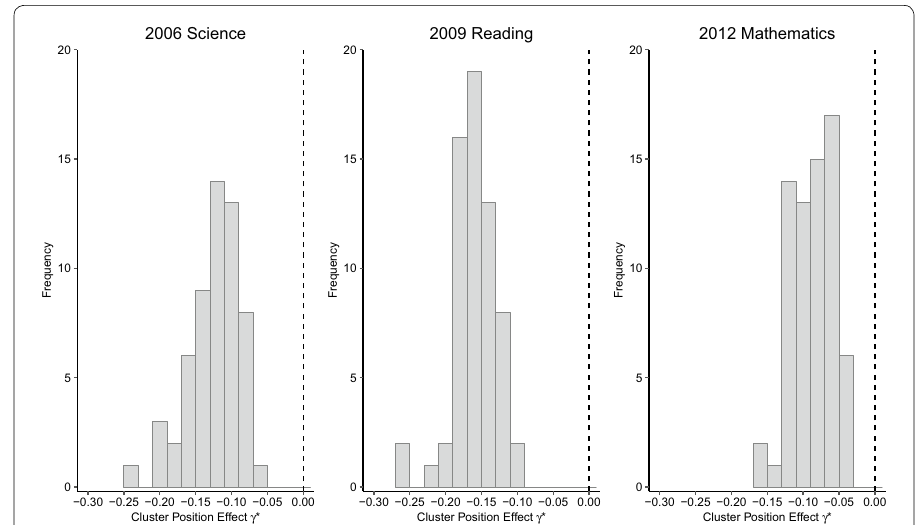
Fig. 1 The histograms of cluster position effects γ ∗ of all countries in the three PISA domains. The dotted lines indicate the value of zero. All effects are significantly different from zero at an alpha level of